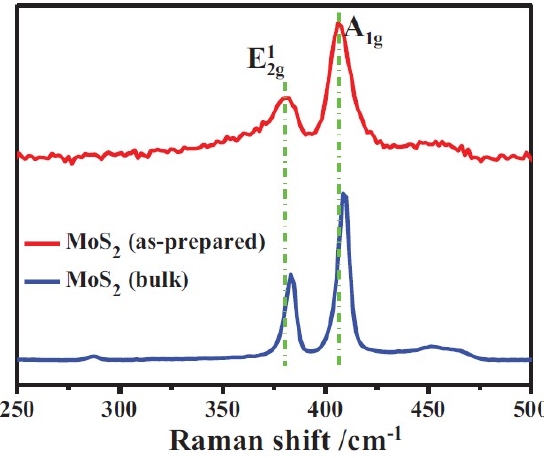
Figure 17. Raman characteristics of as-prepared (red line) and bulk MoS 2 (blue line) [48]. Table 3. The S 2p and Mo 3d XPS peak parameters of the as-prepared MoS 2 monolayer [48].